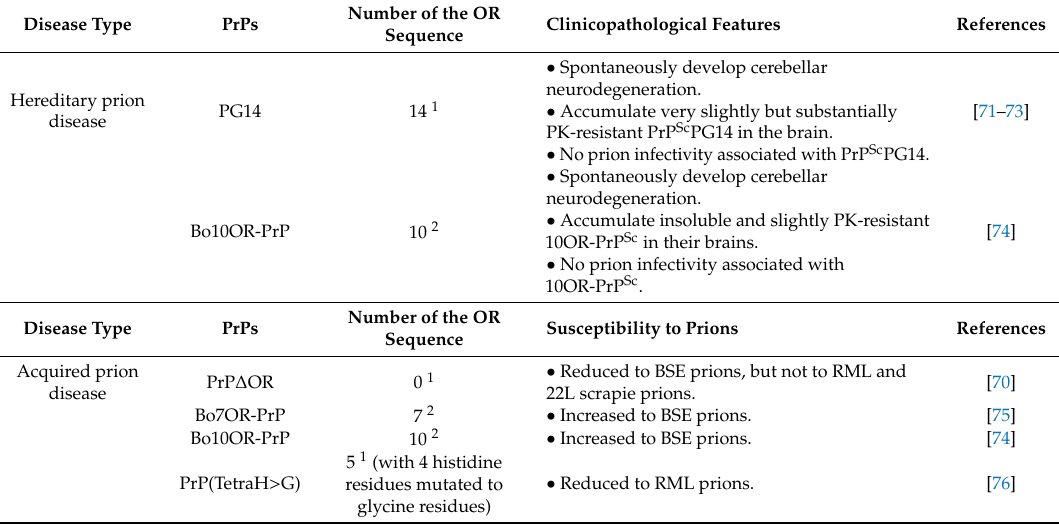
Table 2. E ff ects of various mutations in the OR region of PrP C on hereditary and acquired prion diseases. Disease